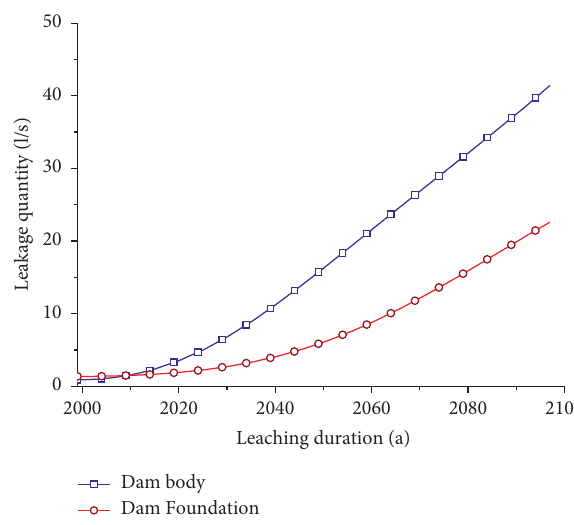
Figure 17: Evolution of the dam body and foundation leakage quantity over a